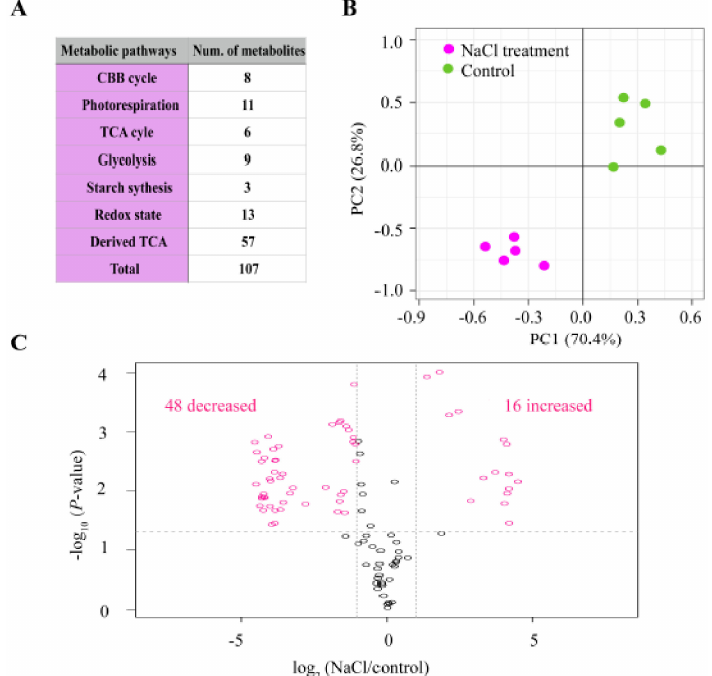
Figure 7. Statistical analysis of 107 targeted metabolites determined with LC-MS / MS in alfalfa seedlings enduring 200 mM NaCl for 14 d. ( A ) Number of metabolites determined for di ff erent metabolic pathways. ( B ) Principal component analysis (PCA) of five di ff erent biological replicates for either control without salt (control) or treated with 200 mM NaCl treatment for 14 d (NaCl). ( C ) Volcano plot representing the di ff erentially abundant metabolites (DAMs) in alfalfa seedlings enduring the same salt concentration for the same duration (200 mM for 14